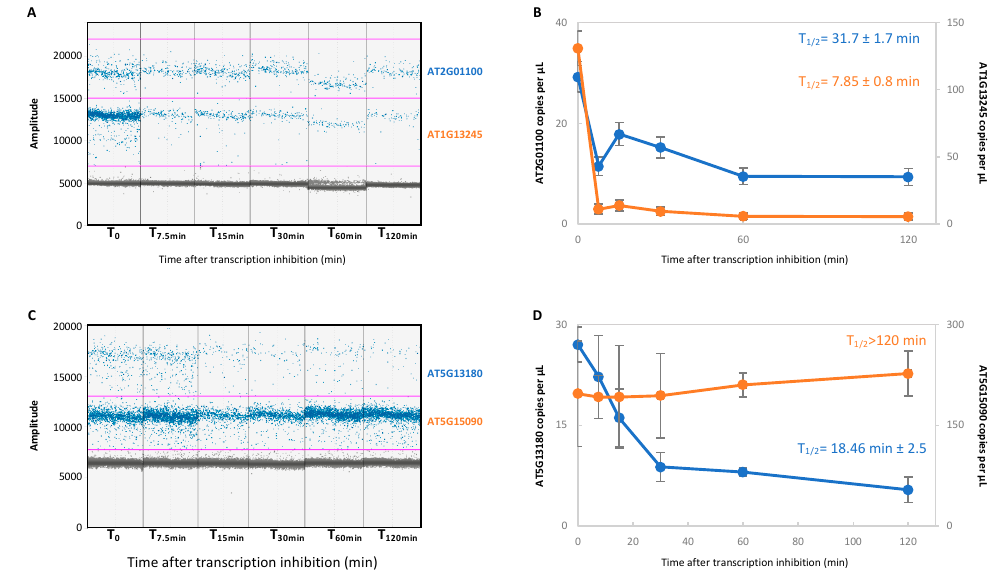
Figure 3. ddPCR allows monitoring of the mRNA half-life of 2 transcripts in the same reaction. ( A ). Multiplexed ddPCR target detection of AT1G13245 and AT2G01100 transcripts. Multiplexed detection (based on differences in amplicon lengths) was achieved by combining the AT1G13245 and AT2G01100 primers into a single reaction. The blue and grey dots correspond, respectively, to the positive and negative droplets. The pink lines correspond to the threshold and were manually applied at 7000 and 15,000 to AT1G13245 and AT2G01100, respectively. ( B ). The number of copies per µ L obtained in ( A ). ( C ). Multiplexed ddPCR target detection of AT5G15090 and AT5G13180 transcripts. The pink lines correspond to the threshold and were manually applied at 7000 and 13,000 to AT5G15090 and AT5G13180, respectively. ( D ). The number of copies per µ L obtained in ( A ). N = 3 biological replicates. Mean ± SD.